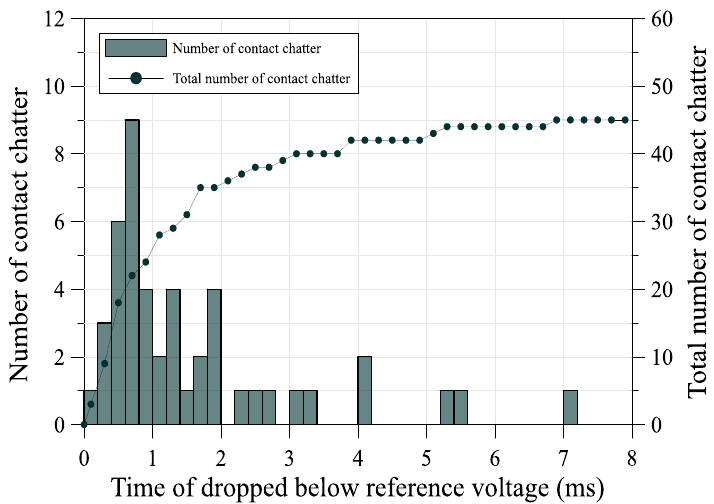
Figure 17. Contact chatter numbers when voltage decreased to below the reference voltage.